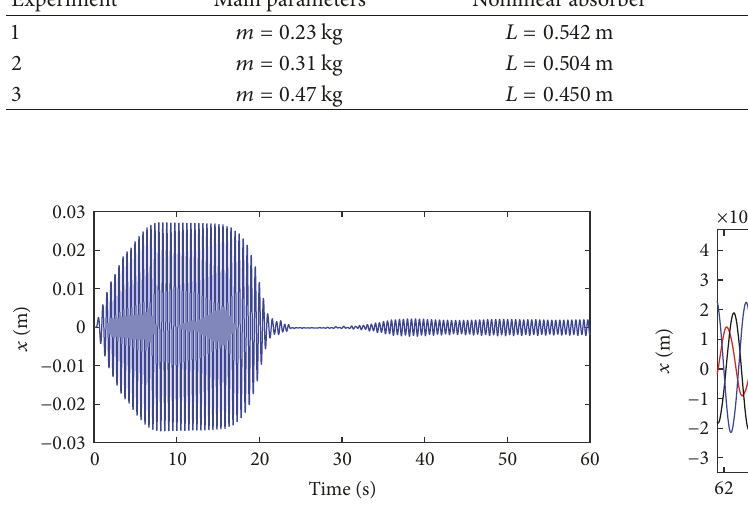
Figure 8: Experimental response for the primary system obtained with the parameters of the second experiment.